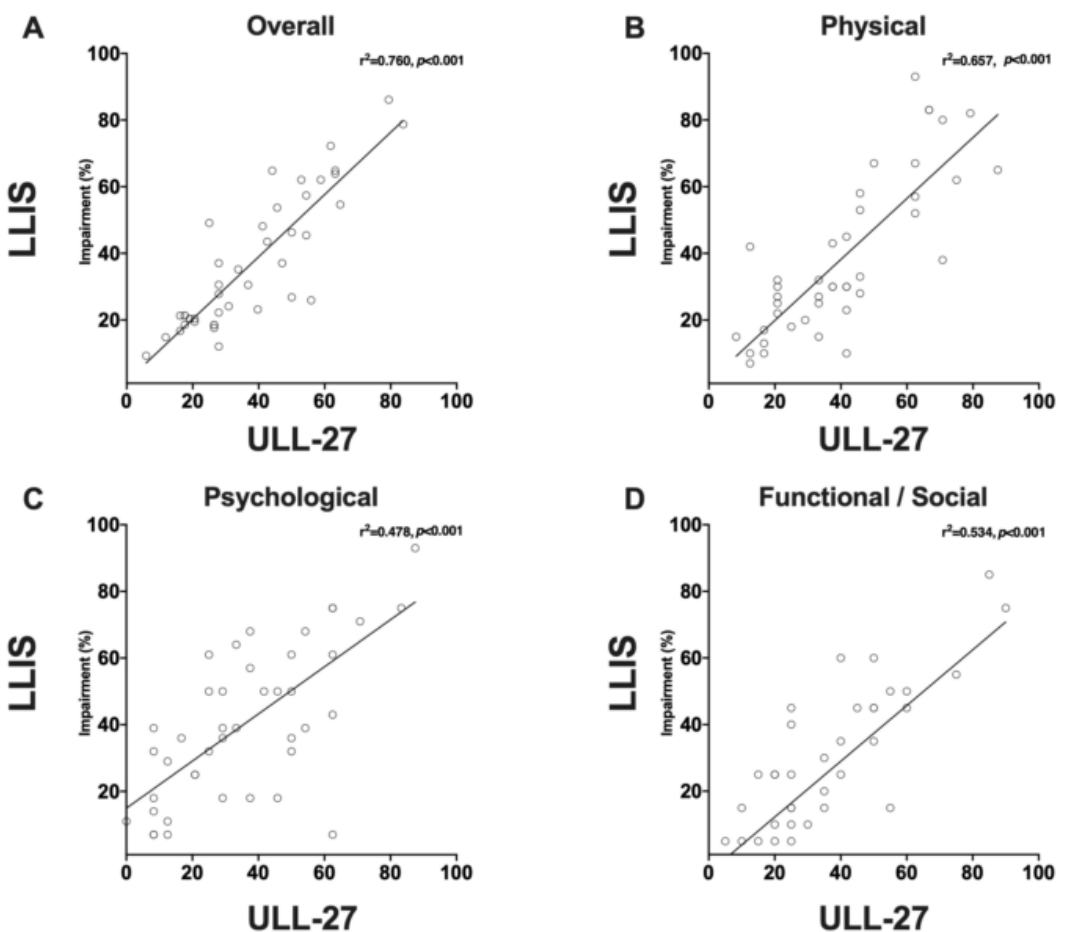
Figure 4. ( A ) Correlation plot of ULL-27 vs. LLIS total impairment score (%). ( B ) Correlation plot of ULL-27 vs. LLIS physical domain impairment score (%). ( C ) Correlation plot of ULL-27 vs. LLIS psychological domain impairment score (%). ( D ) Correlation plot of ULL-27 social vs. LLIS functional domain impairment score (%).